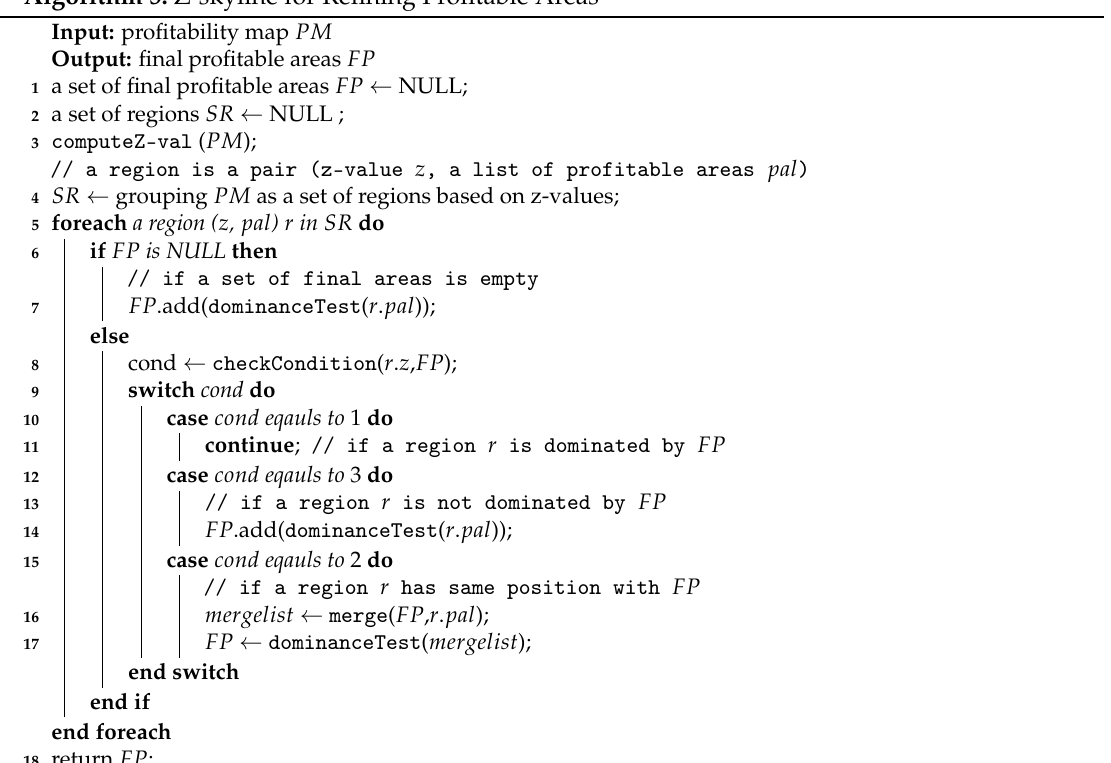
Algorithm 5: Z-skyline for Refining Profitable